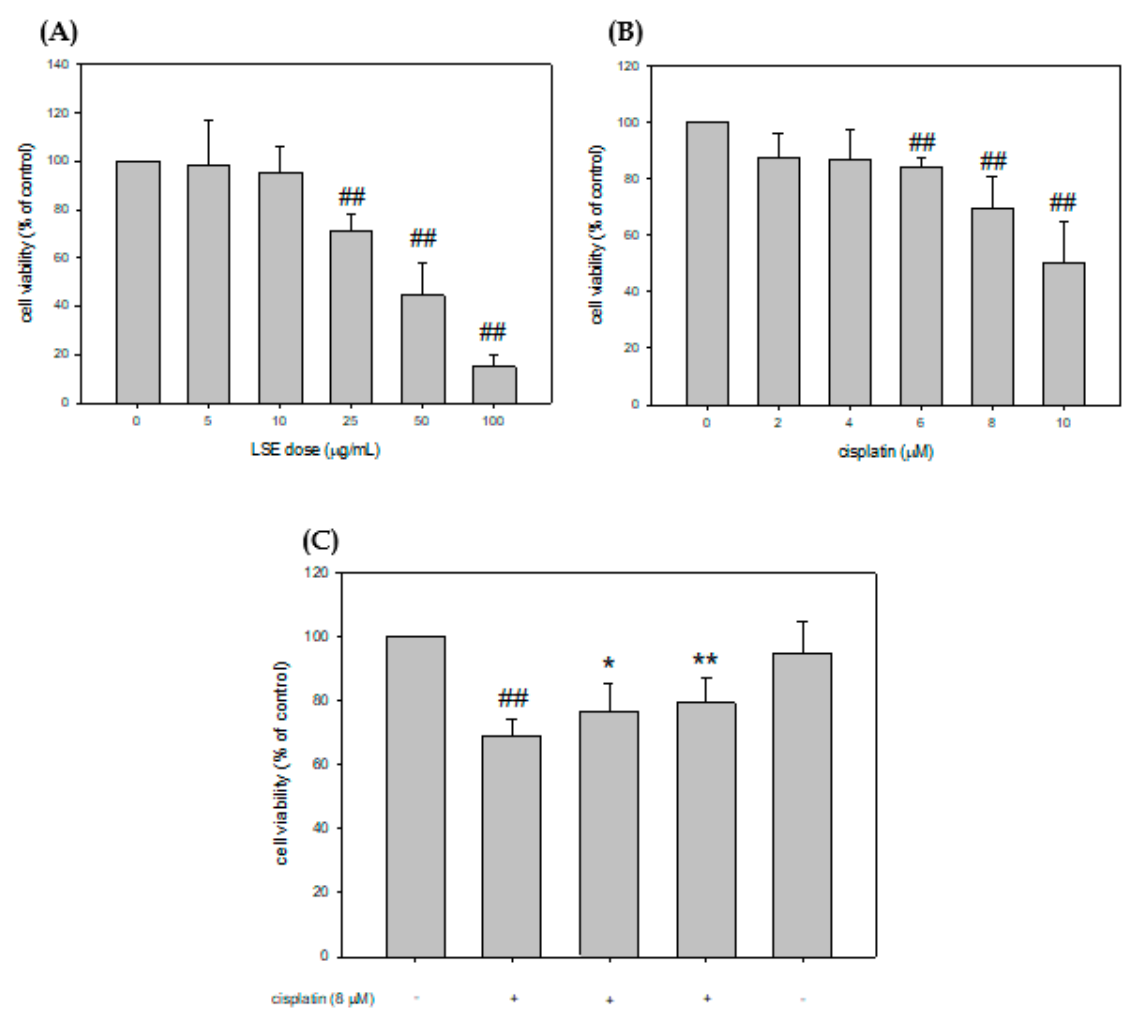
Figure 1. Effect of LSE on the survival of NRK − 52E cells and effect of cisplatin with/without LSE on NRK-52E cell viability. ( A ) NRK − 52E cells were treated with 0, 5, 10, 25, 50, and 100 µ g/mL of LSE for 24 h. Cellular survival was measured by Guava ® Muse ® cell analyzer. ( B ) NRK − 52E cells were treated with 0, 2, 4, 6, 8, and 10 µ M of cisplatin for 24 h. Cell survival was measured by Guava ® Muse ® cell analyzer. ( C ) NRK − 52E cells were treated with or without LSE (5, 10 µ g/mL) for 24 h in the presence or absence of cisplatin (8 µ M). Quantification data were presented as mean ± SD of three independent experiments by using Sigma plot 10.0 software. ## p < 0.01 compared with the control group; * p < 0.05, ** p < 0.01 compared with the cisplatin group.